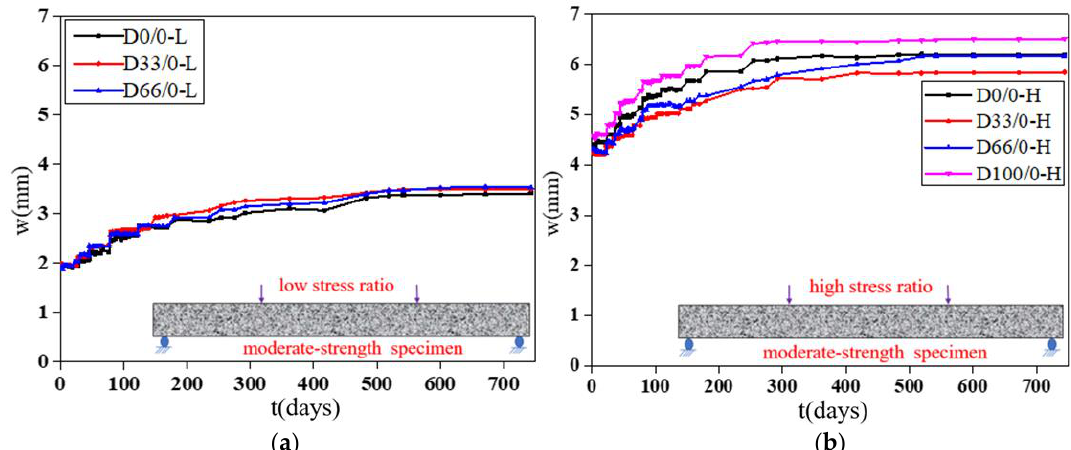
Figure 8. Deflection-load holding time curves of the moderate strength specimens. ( a ) Specimens under a low stress ratio; ( b ) specimens under a high stress ratio.